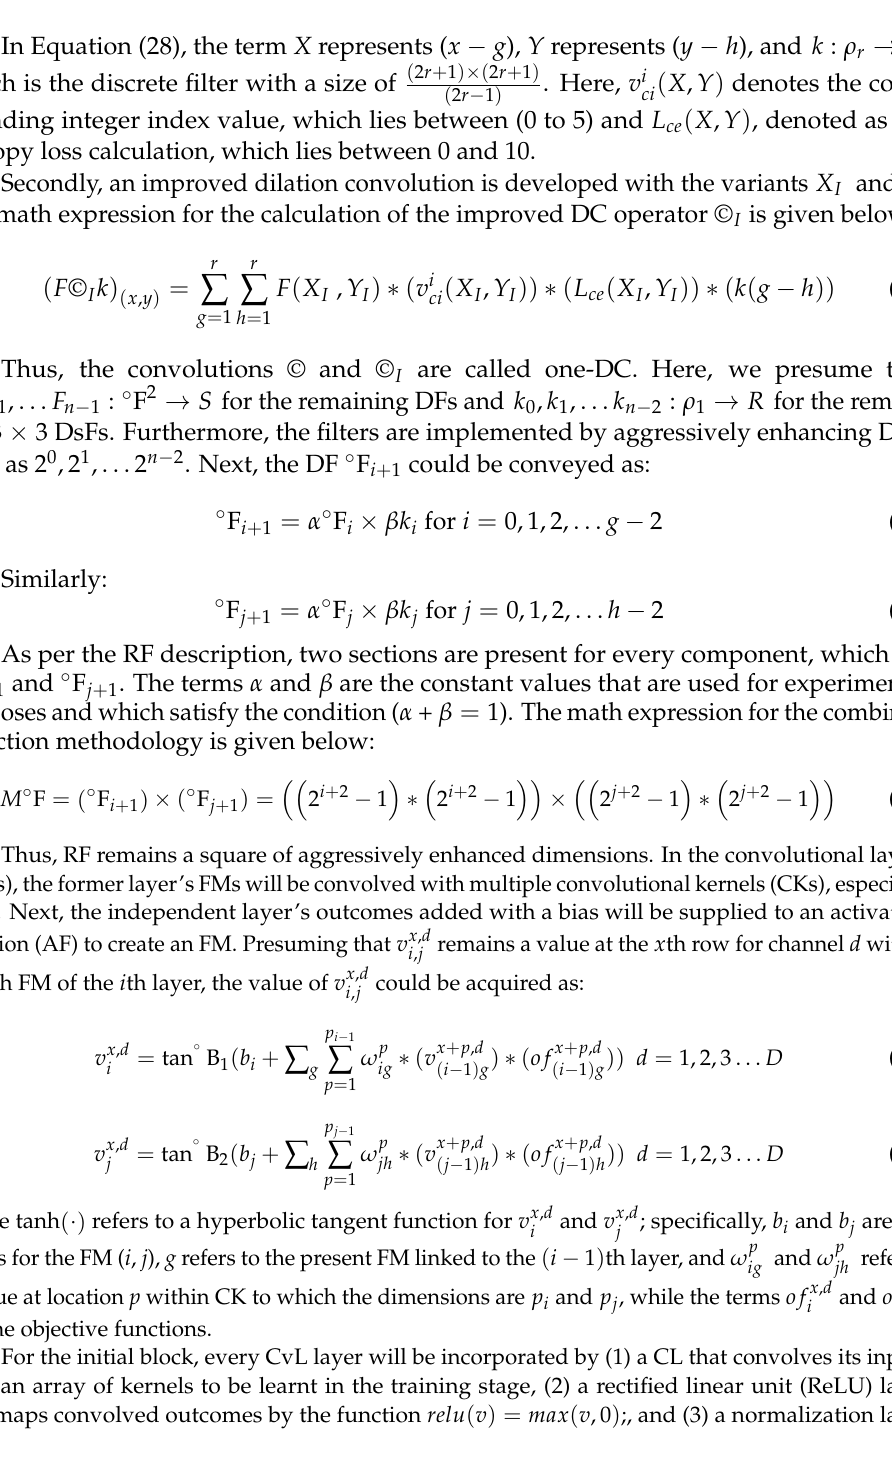
Figure 2. ACAE framework.